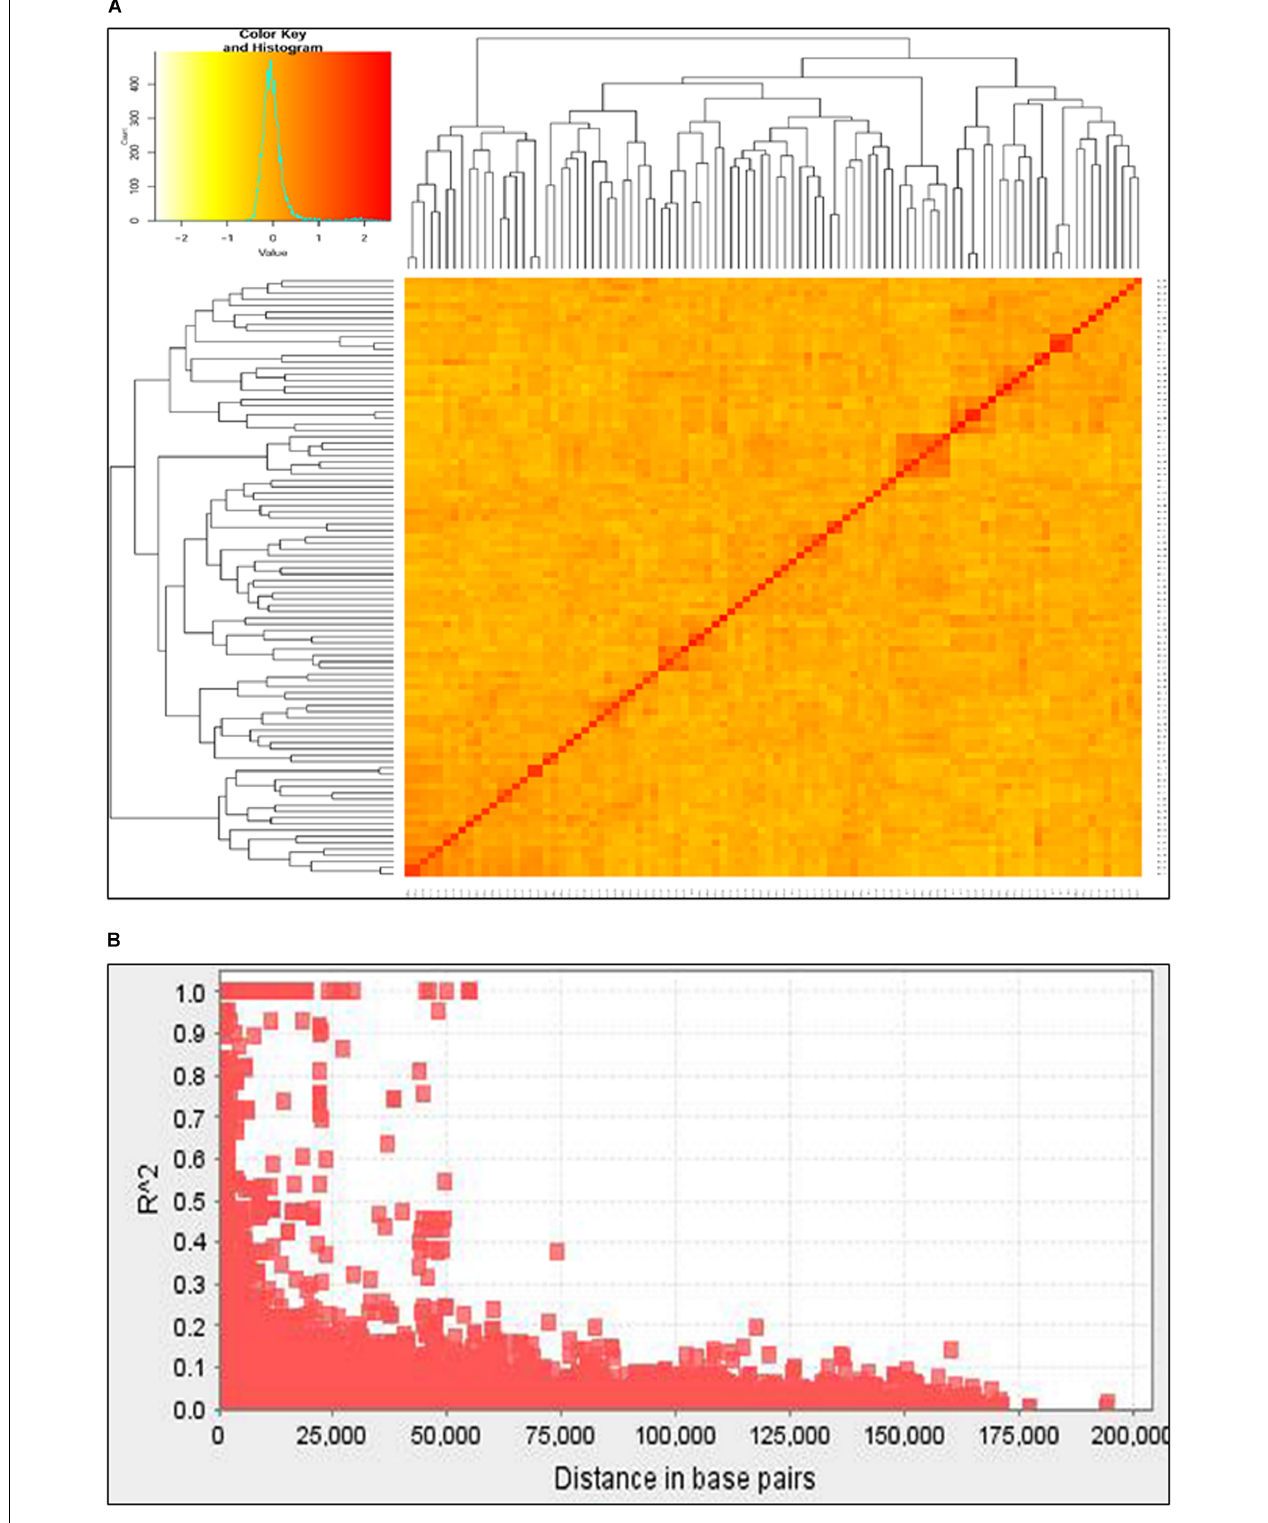
FIGURE 2 | Major clusters of the 91 wheat collections based on unweighted pair group method with arithmetic mean (UPGMA) algorism (A) and genome-wide average LD (B) over genetic distance (bp).